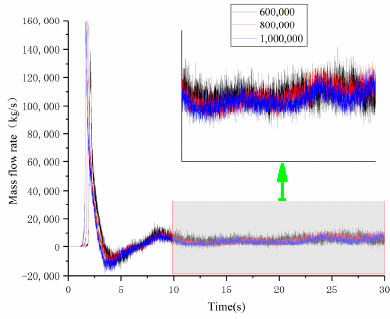
Figure 13. Curve of particle mass flow with time in different mesh models.